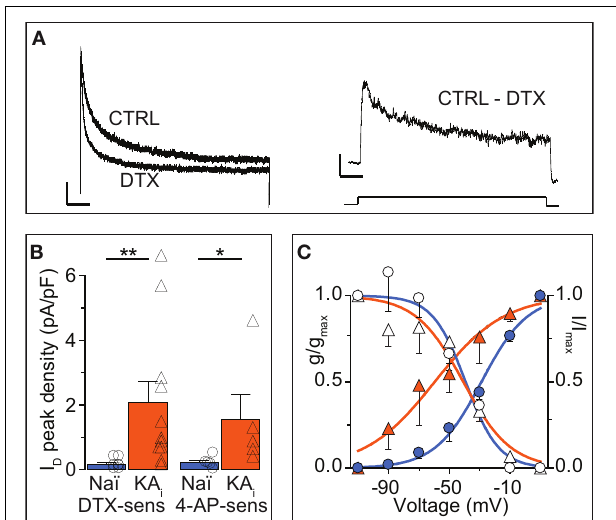
FIGURE 3 | Voltage-clamp characterization of the I D of DG cells. (A) Dendrotoxin (DTX, 100nM)-sensitive currents (I D ) were obtained in voltage-clamp by offline subtraction of currents after DTX application from those before ( CTRL ). Scale bars , 500ms, left panel , 100pA, right panel , 50 pA. Lower panel , 2.5s-long voltage step from − 100 to 0mV). (B) Peak I D current densities from experiments as in A using DTX and 40 μ M 4-AP. The DG cells of KA-injected hippocampi had strongly increased DTX- and 40 μ M 4-AP-sensitive I D amplitudes. (C) To determine the voltage dependence of activation, the DTX-sensitive I D was evoked by voltage steps from − 110 to